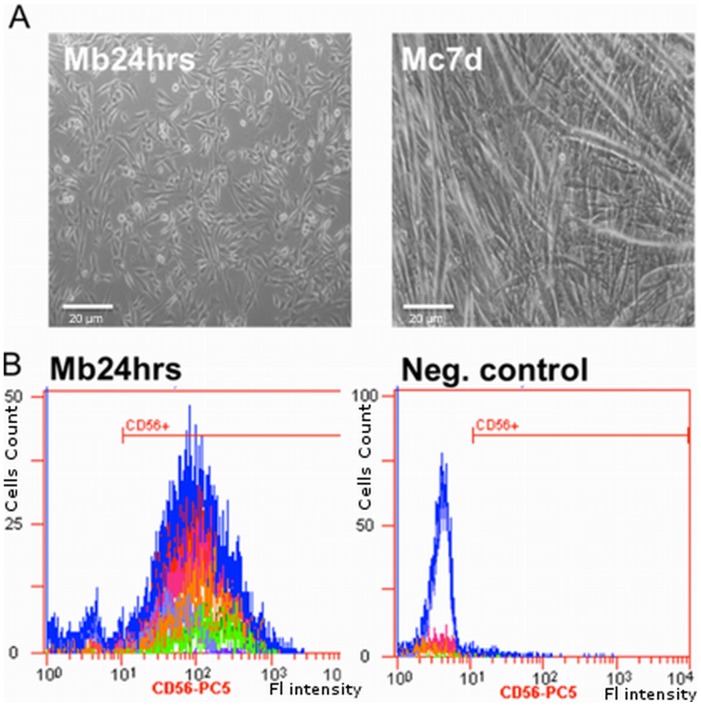
Human myoblasts in in vitro culture.A – flow cytometry analysis of CD56 expression on human myoblasts. Mean percent of cells positive for the CD56 marker: 85.0+/−5.0%. Panel B - in vitro culture of myoblasts and myocytes (Mb24 hrs – proliferating myoblasts; Mc7d- fused myocytes (myotubes). magnification-100x).